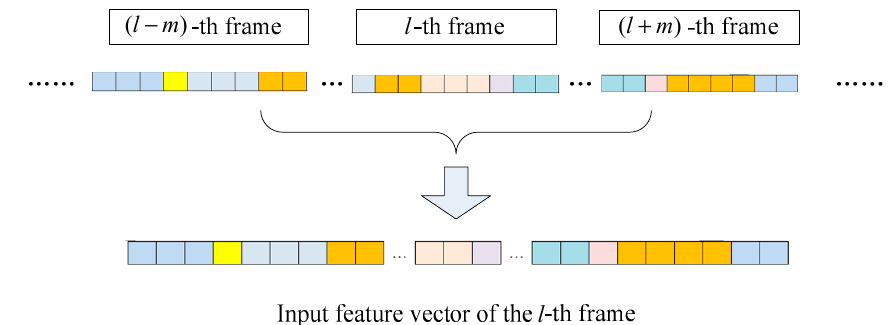
Figure 4. Input vector construction.